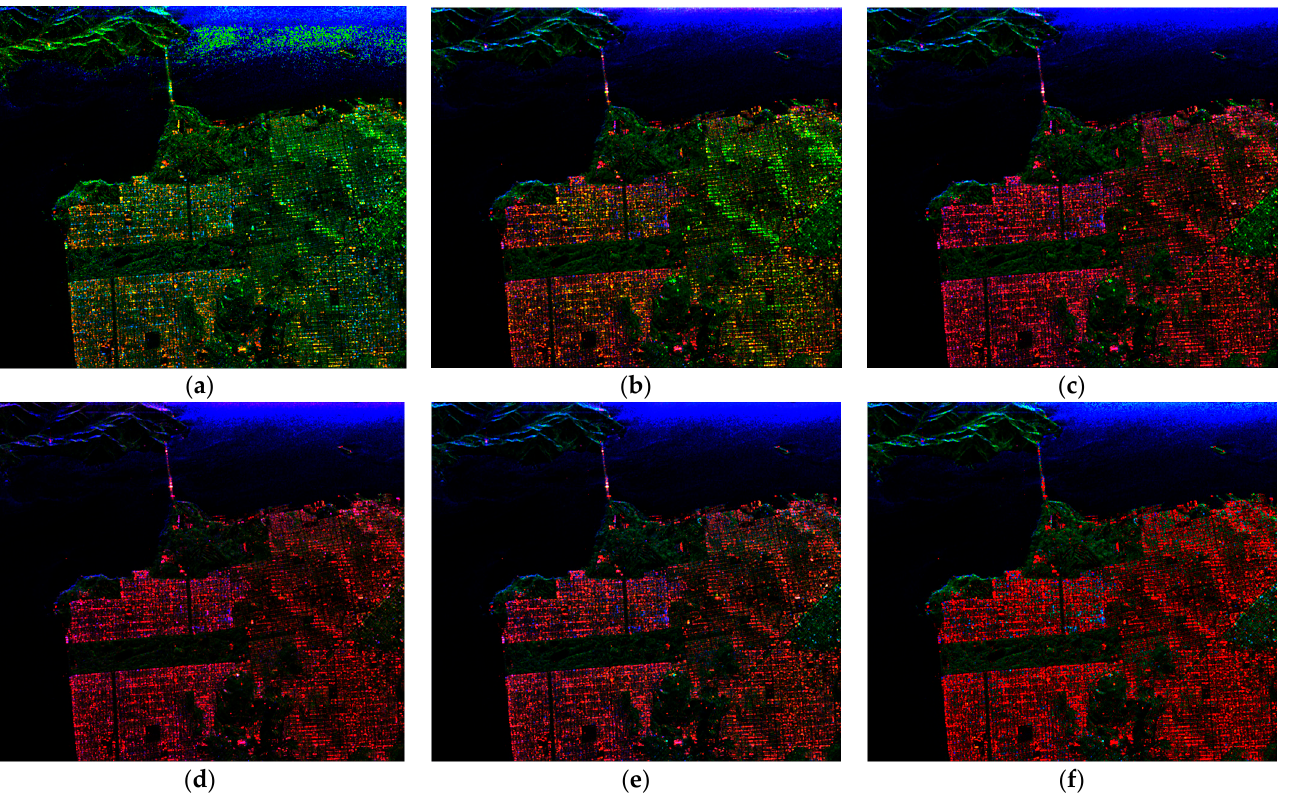
Figure 6. Pseudo-color images of the polarimetric target decomposition results. Red: double-bounce scattering ( Pd ); Green: volume scattering ( Pv ); Blue: surface scattering ( Ps ). ( a ) FRE2; ( b ) YRO; ( c ) Y4R; ( d ) MF4CF; ( e ) HTCD; ( f ) GRH.